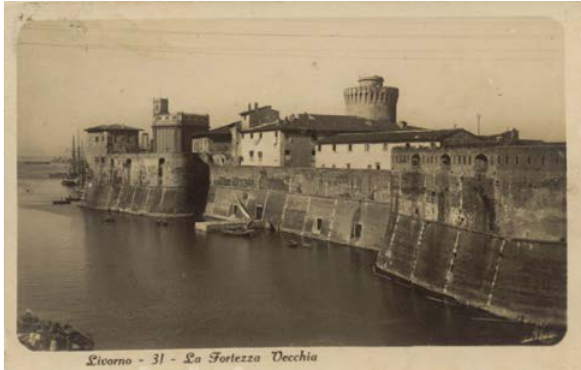
Figure 6: Archive image of the South side of Palazzo di Cosimo ( Collezione Pelosini , Courtesy Biblioteca Labronica F.D.